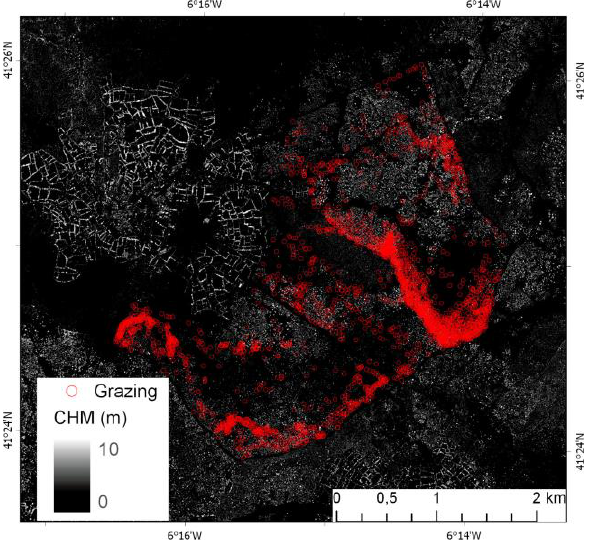
Figure 4. CHM over the study area, with the GPS